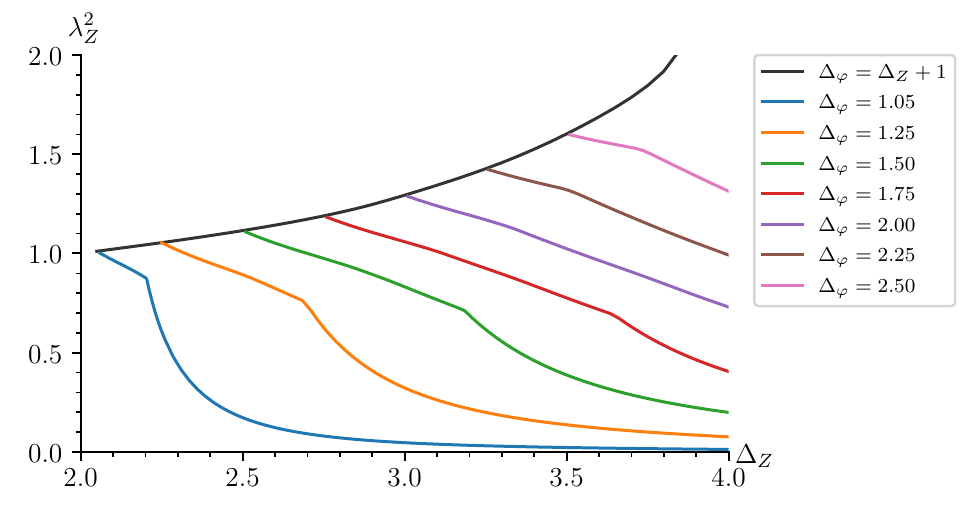
Figure 11 . Upper bounds on the OPE coefficient of a long scalar multiplet of dimension ∆ Z in the ϕ × M OPE, for different dimensions of the Coulomb branch operator ϕ . Notice we do not assume that ∆ Z is the lowest dimension of an operator in the Z channel. The black line corresponds to the upper bound for the operator ϕM at the unitarity bound ∆ Z = ∆ ϕ + 1 . All results are obtained with Λ = 24